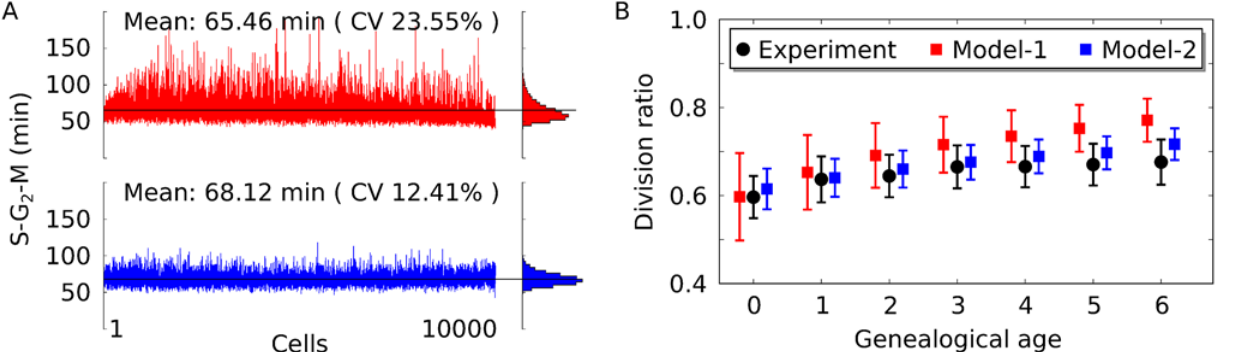
Fig 4. A growth rate dependent bud sizer tunes mitotic entry to maintain size ratios at division. (A) Deviation around the mean duration of the budded phase (S-G 2 -M) is shown for fast growing cells (glucose) simulated with Model-1 (red) and Model-2 (blue). The mean of the data (black line) and the coefficient of variation (CV) are also shown. (B) Volume fraction of cell and bud at division is shown as a function of replicative age for data from experiments [41] (black dots) and from simulations with Model-1 (red squares) and Model-2 (blue